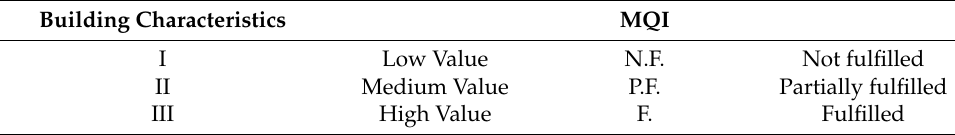
Table 1. Input parameters: main values.